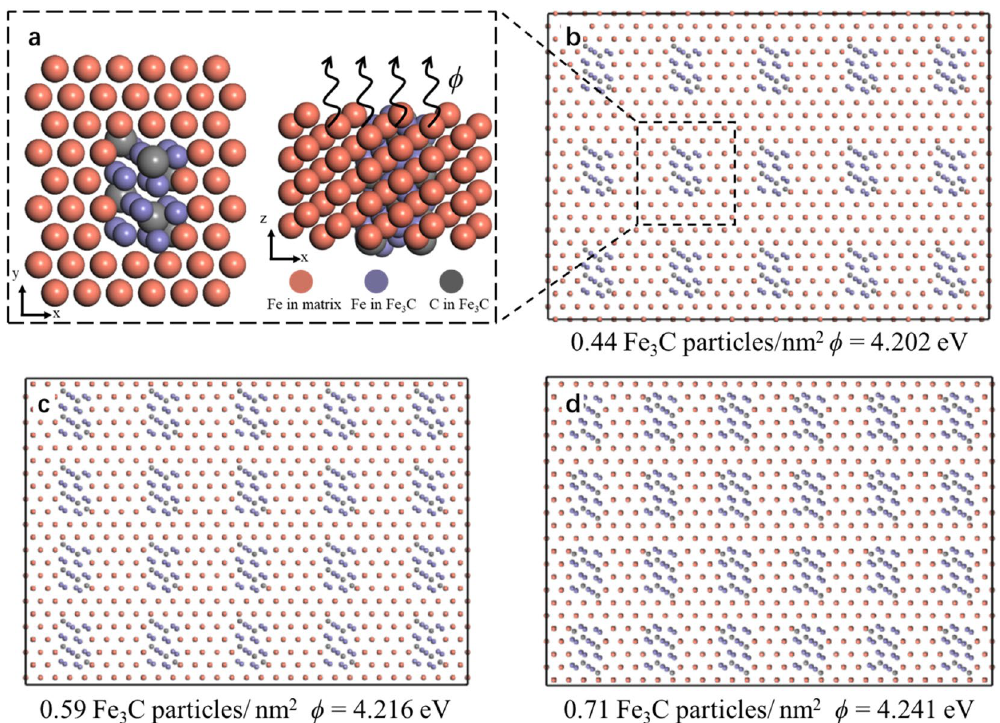
Figure 7. Schematic interface between Fe and Fe 3 C with three different configurations. ( a ) Fe/Fe 3 C interface influences the escape of electrons at fermi level from inside the system consisting of cementite and α-Fe matrix (ferrite) to vacuum. ( b – d ) Three systems with different distribution densities of cementite in the α-Fe matrix and corresponding work